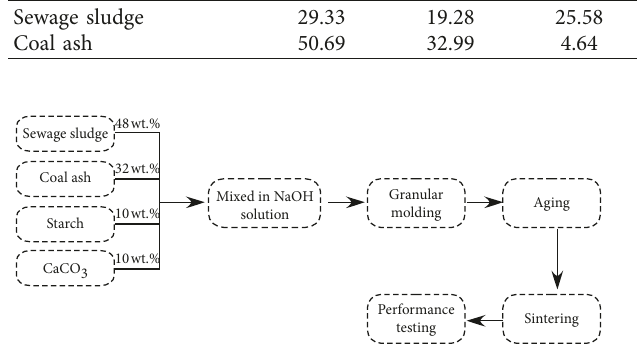
Figure 1: Preparatory flowchart for the porous ceramic